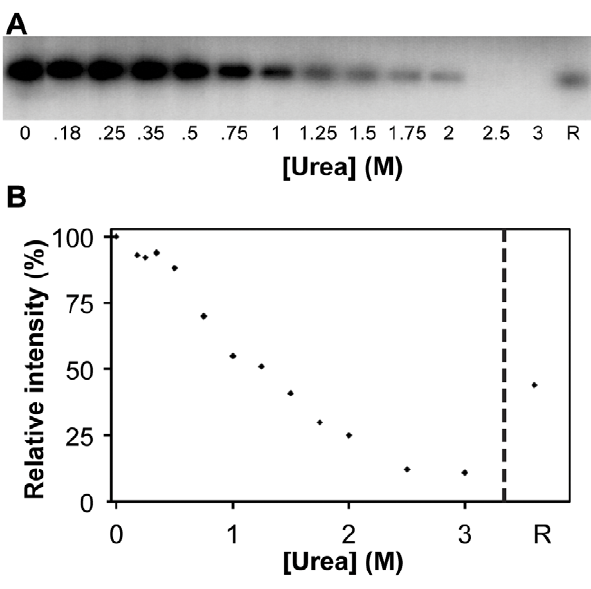
Figure 6. Dependence of SERK1-KD kinase activity on urea concentration. ( A ) Autoradiograph of autophosphorylation activity of SERK1-KD at different concentrations of urea. R: Refolded SERK1-KD, obtained by unfolding the protein for a period of 2 hours in 3 M urea and subsequent dilution of denaturant to 0.18 M urea. Refolding took place during a period of 30 min at room temperature. ( B ) Urea- dependent loss of phosphorylation activity of SERK1-KD. The gel presented in (A) is analysed with ImageJ to quantify intensities of the bands observed, which correlates with incorporation of radioactive phosphate. Loss of kinase activity happens gradually upon increasing urea concentration above 0.5 M. Phosphorylation activity is completely lost at concentrations urea above 2